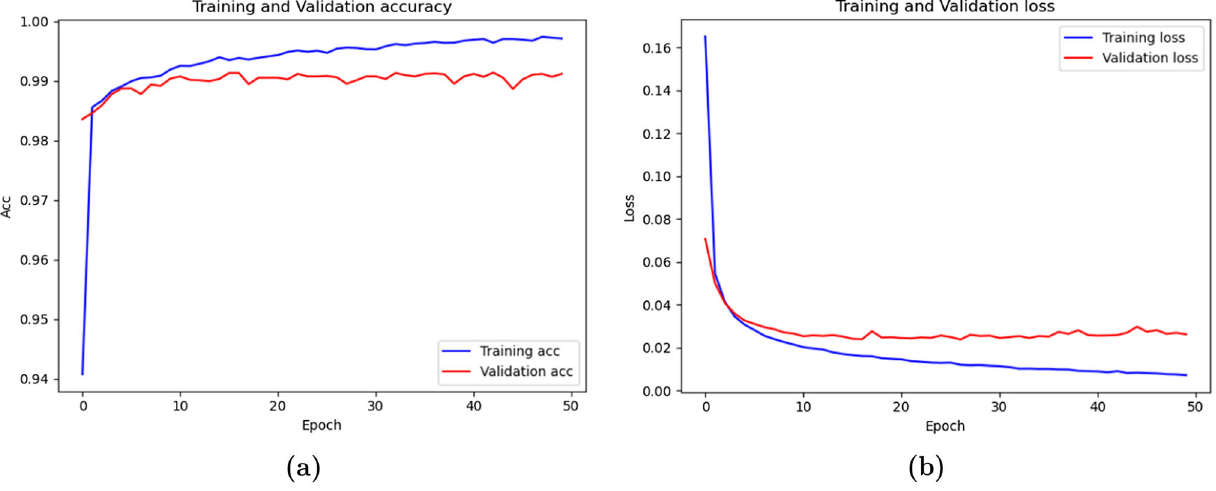
Fig. 5 The loss and accuracy graph of the training and validation of QRAN. Variation of accuracy with epochs is in ( a ); variation of loss with epochs is in ( b